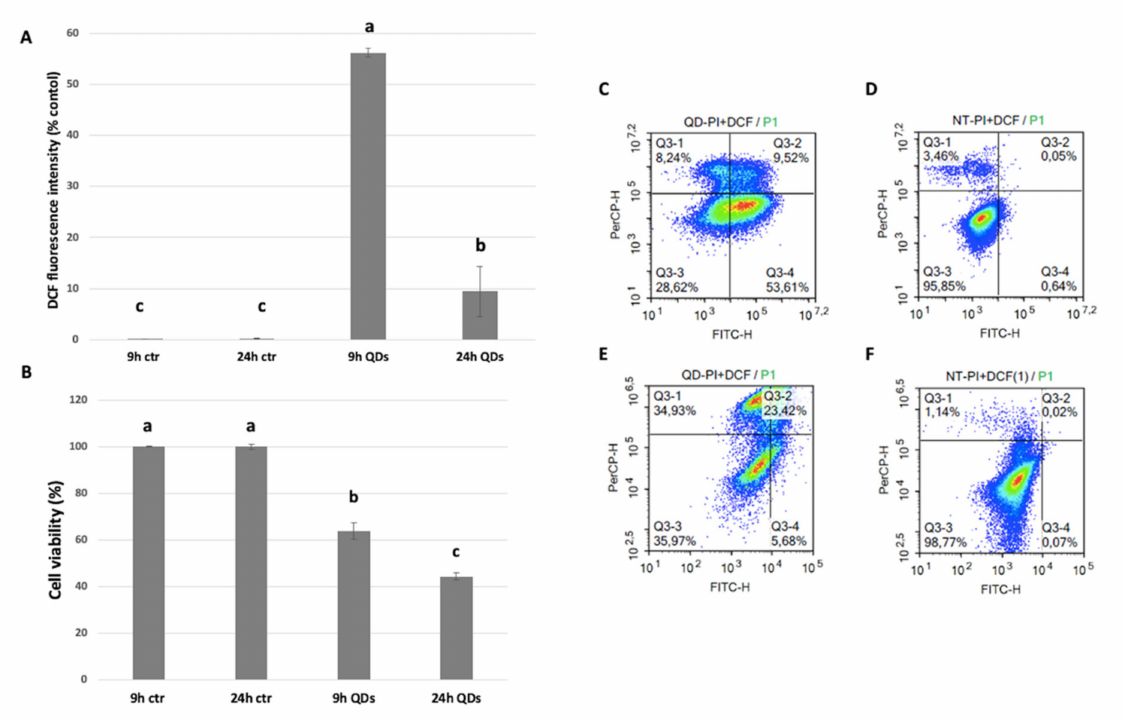
Figure 2. Flow cytometric measurements. The bars represent the average of 4 independent replicates. ANOVA was carried out followed by the Bonferroni post hoc test. Di ff erent letters indicate a statistic di ff erence with p < 0.001: ( A ) changes in intracellular ROS; ( B ) cell viability evaluated by flow cytometry with propidium iodide. Yeast were stained with DCFHDA (2’-7’ Dichlorofluresceine diacetate) and PI (Propidium iodide) and detected by flow cytometry after 30 min incubation in the dark. The lateral axis represents the fluorescence of DCFH while the vertical axis indicates the PI intensity of detected cells. ( C ) Control for 9 h; ( D ) treatment for 9 h; ( E ) control for 24 h; ( F ) treatment for 24